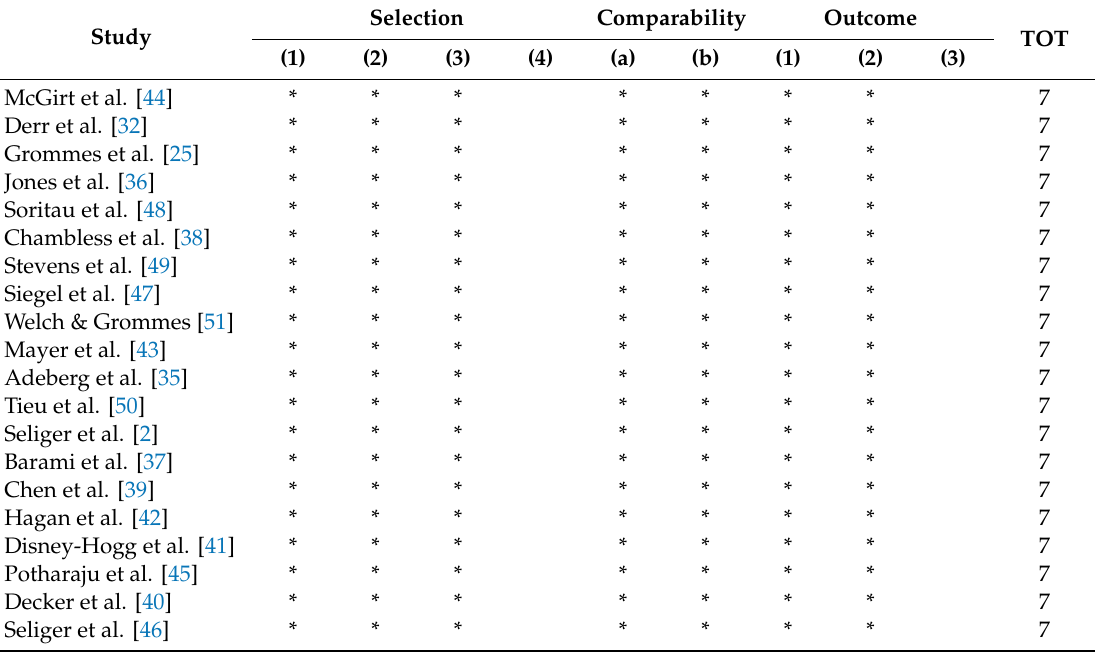
Table 3. Quality measure of included studies by the Newcastle–Ottawa quality assessment